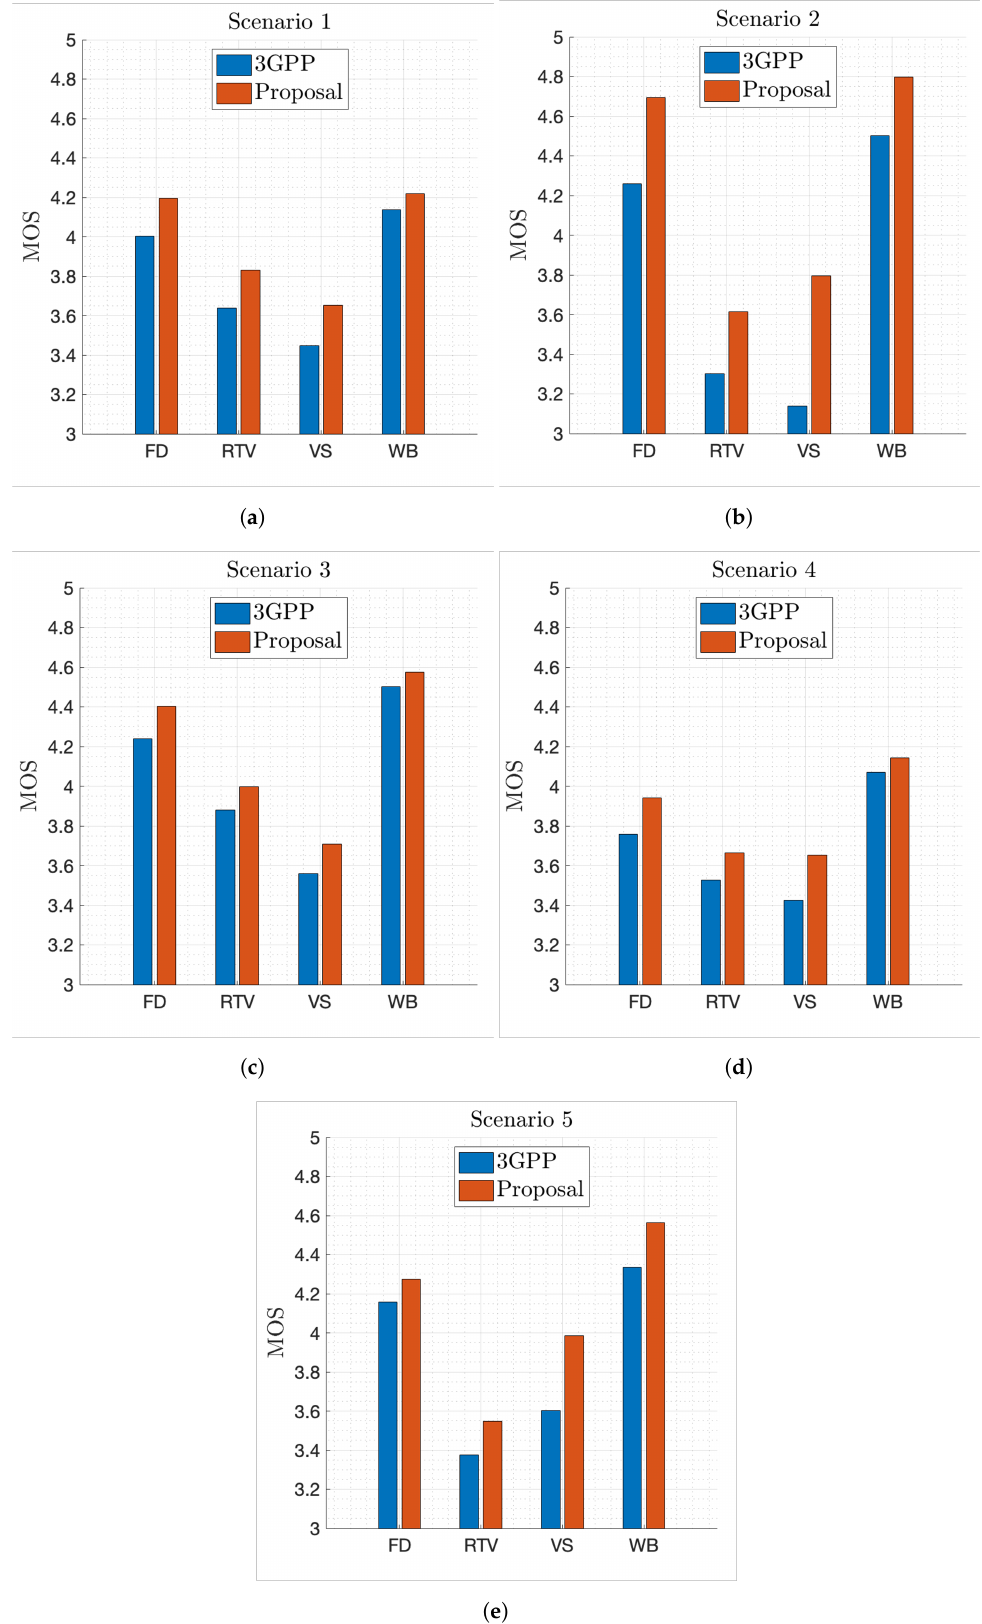
Figure 6. MOS obtained by each solution for each service in every scenario. ( a ) MOS in Scenario 1. ( b ) MOS in Scenario 2. ( c ) MOS in Scenario 3. ( d ) MOS in Scenario 4. ( e ) MOS in Scenario